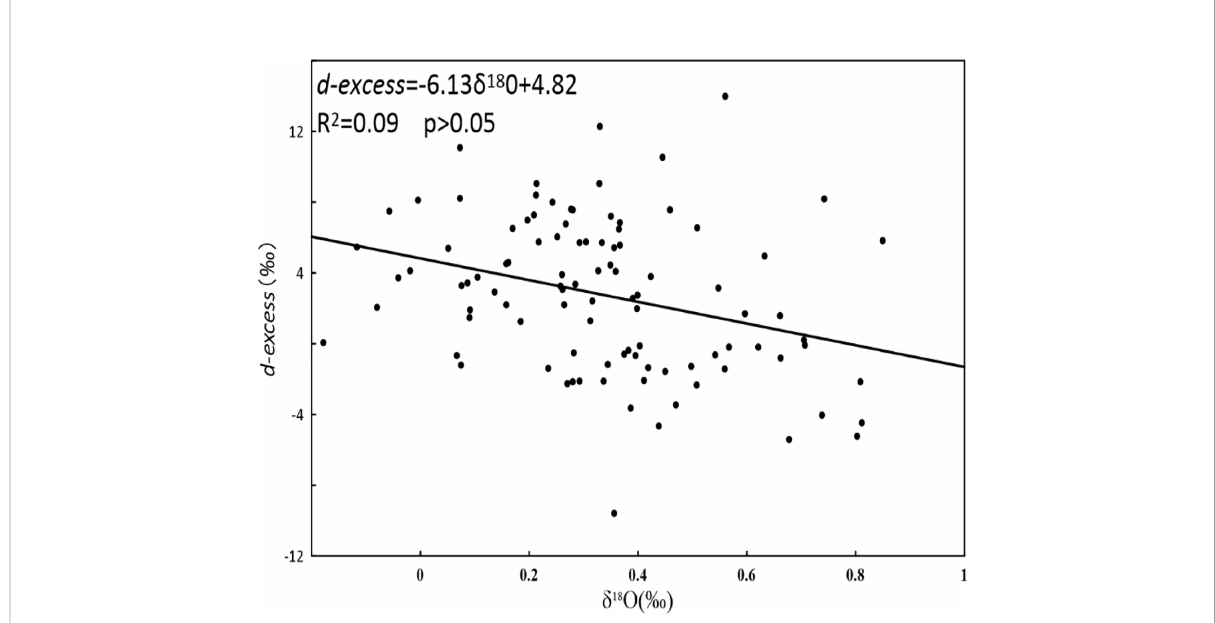
FIGURE 7 d-excess – d 18 O relationship for seawater samples collected in different